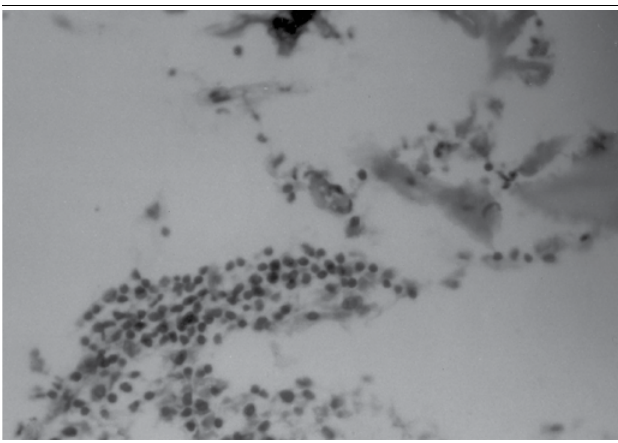
figurE 3 – Bone marrow biopsy shows focal infiltration with lymphocytes similar to those in the peripheral blood